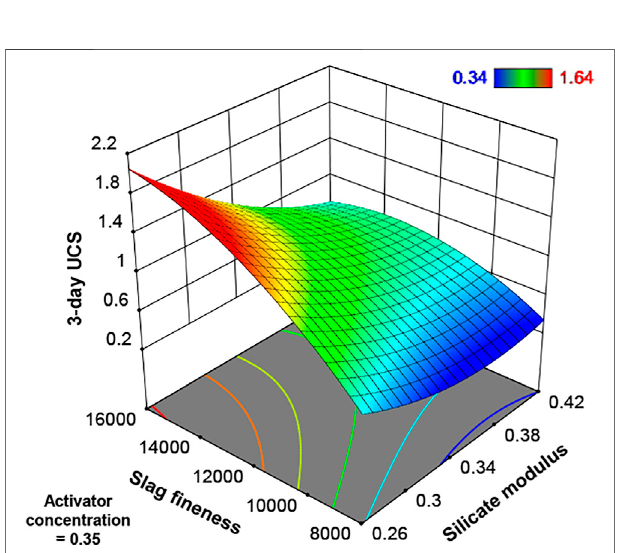
FIGURE 5 | Measured and predicted strengths for 3 day (A) and 28 day (B) cured AAS-CPB samples.